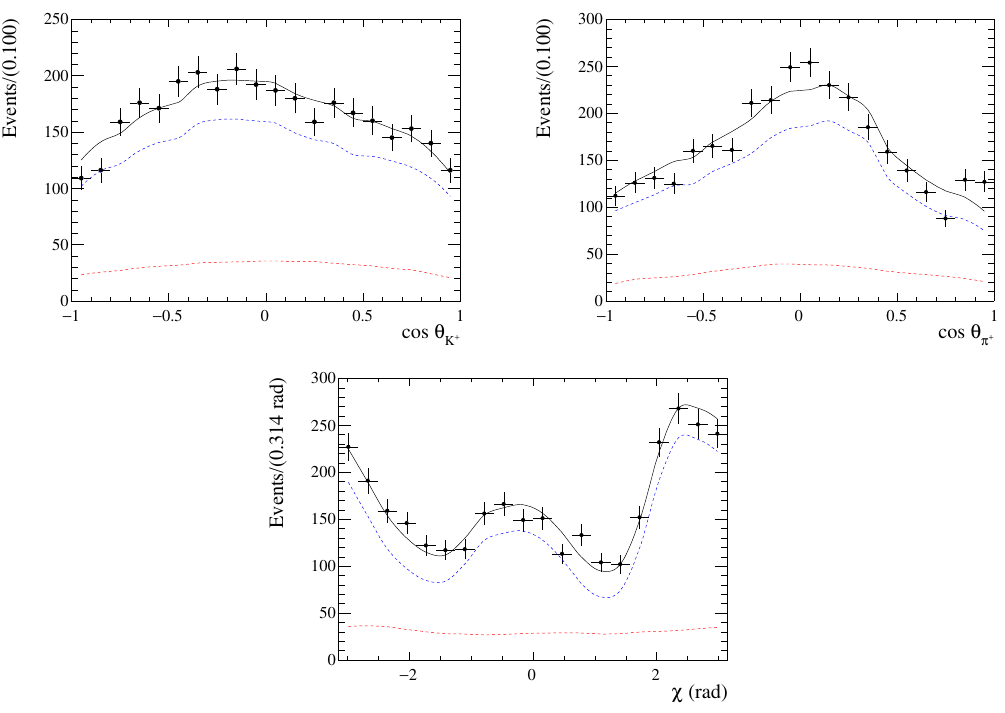
Figure 13 . Angular projections of the D 0 ! K + K (cid:0) (cid:25) + (cid:25) (cid:0) (cid:12)t results (black solid line) in the transversity basis, to the (cid:13)avor-tagged data sample only. The signal component is shown in blue (dashed) and the background component in red